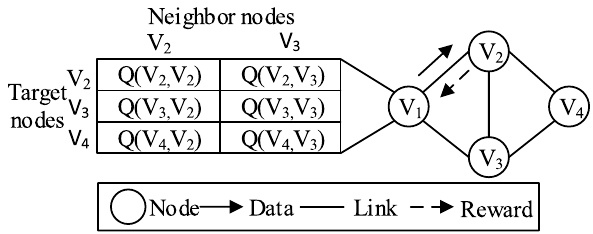
Fig. 5 Table-based routing algorithm